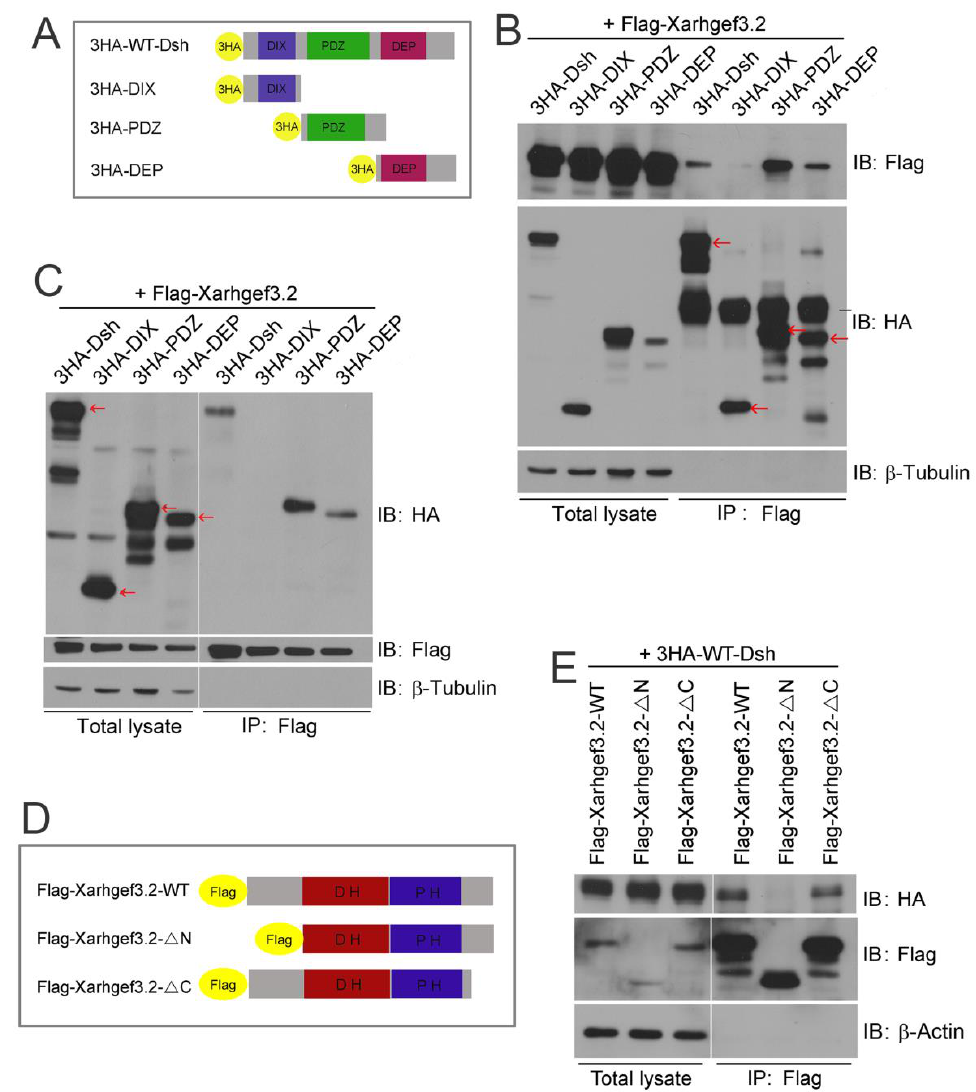
Figure 6. N-terminal region of Xarhgef3.2 is required for interaction with the PDZ and the DEP domain of Dsh2. ( A ) Schematic representation of HA-tagged constructs for Dsh2. ( B , C ) RNAs of Flag-Xarhgef3.2 (100 pg) were co-injected with HA-WT-Dsh2 (1 ng), HA-PDZ (1 ng), or HA-DEP (1 ng) at the one-cell stage. Immunoprecipitation assays were performed with an anti-Flag antibody or an anti-HA antibody at stage 10. The red arrows indicate intact protein bands. ( D ) Schematic representation of Flag-tagged constructs of Xarhgef3.2 . ( E ) RNAs of HA-WT-Dsh2 (1 ng) were co- injected with Flag-WT-Xarhgef3.2 , Flag- ρN - Xarhgef3.2 , or Flag- ρC -Xarhgef3.2 (each, 100 pg) at the one-cell stage. Immunoprecipitation assays were performed with an anti-HA antibody at stage 10.